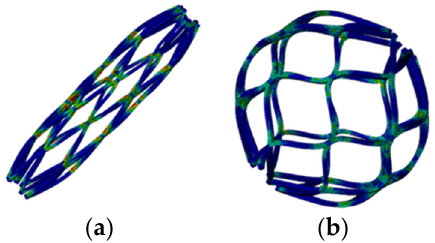
Figure 8. Contour plots of strain distribution during a series of spherical expansions.